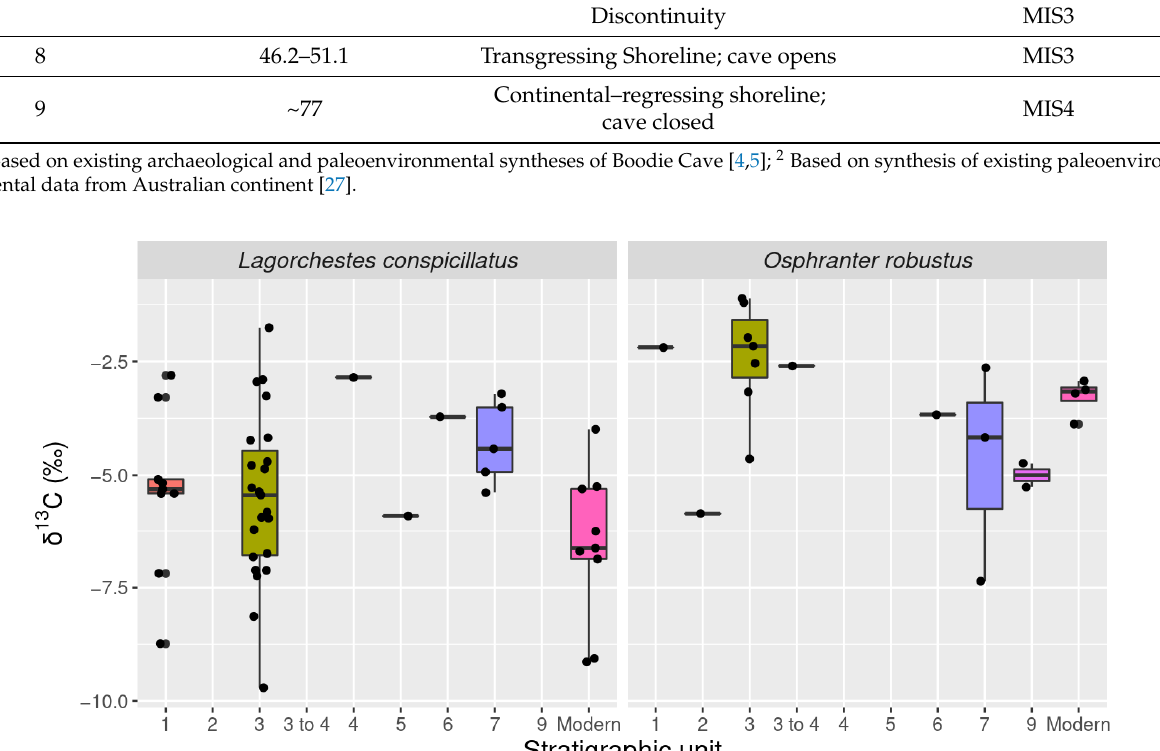
Figure 7. Box plot L. conspicillatus and O. robustus δ 13 C by stratigraphic unit.